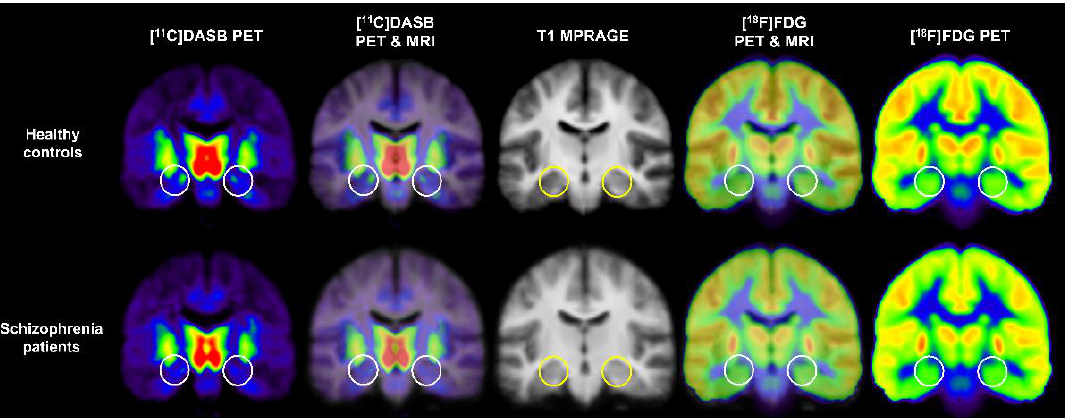
Figure 7. Mean [ 11 C]DASB PET, [ 18 F]FDG PET, T1 MRI, and PET–MRI fusion images of healthy controls and patients with schizophrenia. Circles indicate the location of the bilateral anterior hippo- campus.